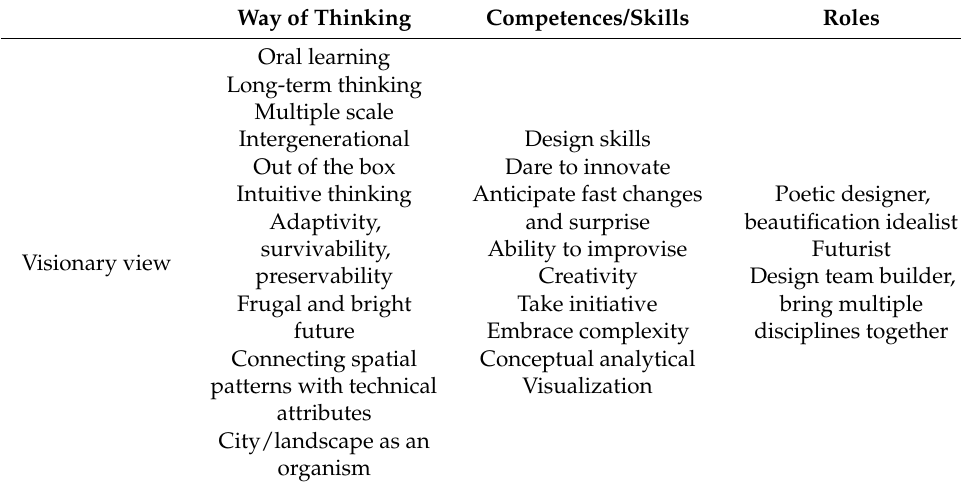
Table 2. Desired skills and roles for the future urban professional.